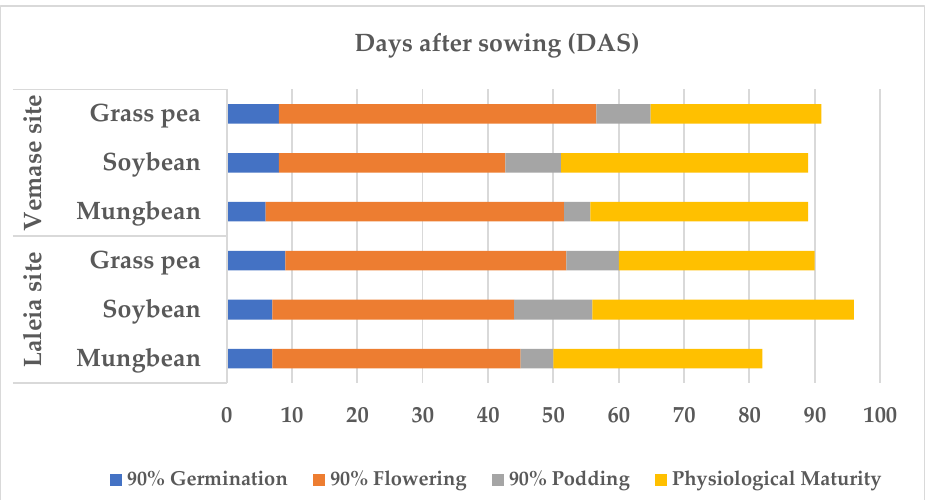
Figure 4. Crop phenology of grain legumes at the Vemase site (2018) and Laleia site (2019).